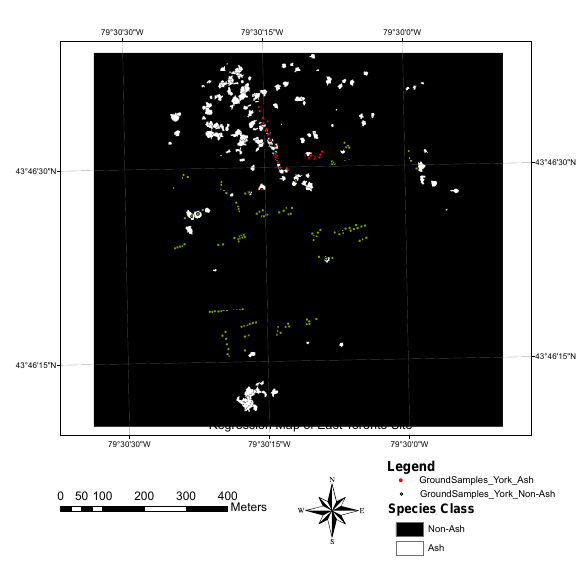
Figure 6. The identified ash trees in Site 1 by thresholding the regression values.